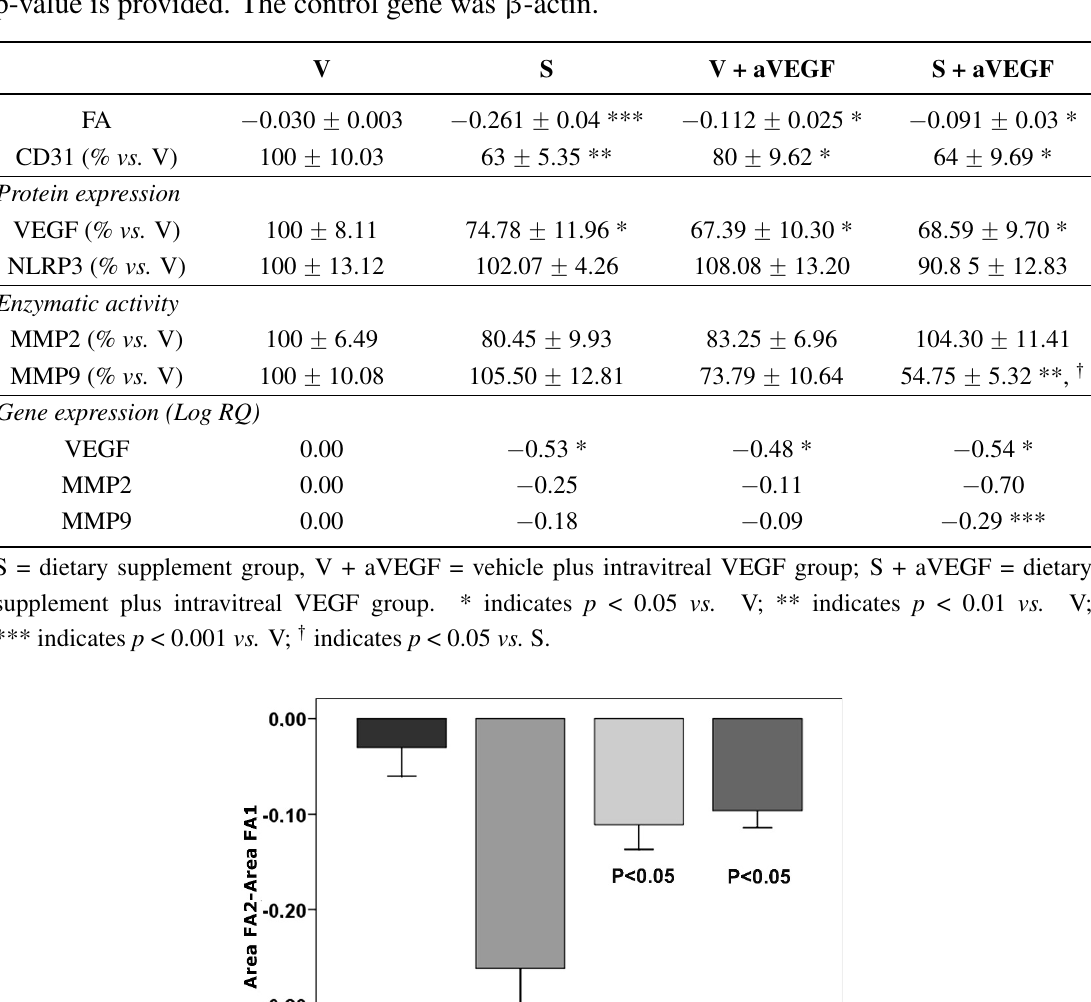
Table 2. Summary of study results. Mean choroidal neovascularization (CNV) area, as assessed by fluorescein angiography (FA) and CD31 (measured in pixels). Vascular endothelial growth factor (VEGF) and NLRP3 protein expression levels and MMP-2 and MMP-9 activity (in percentage of arbitrary units [AU]) compared to the vehicle group (V). Data are shown as mean ˘ standard error of the mean. Real time polymerase chain reaction analysis results are expressed as specific gene logarithm relative quantity (Log RQ) and the p-value is provided. The control gene was β -actin.